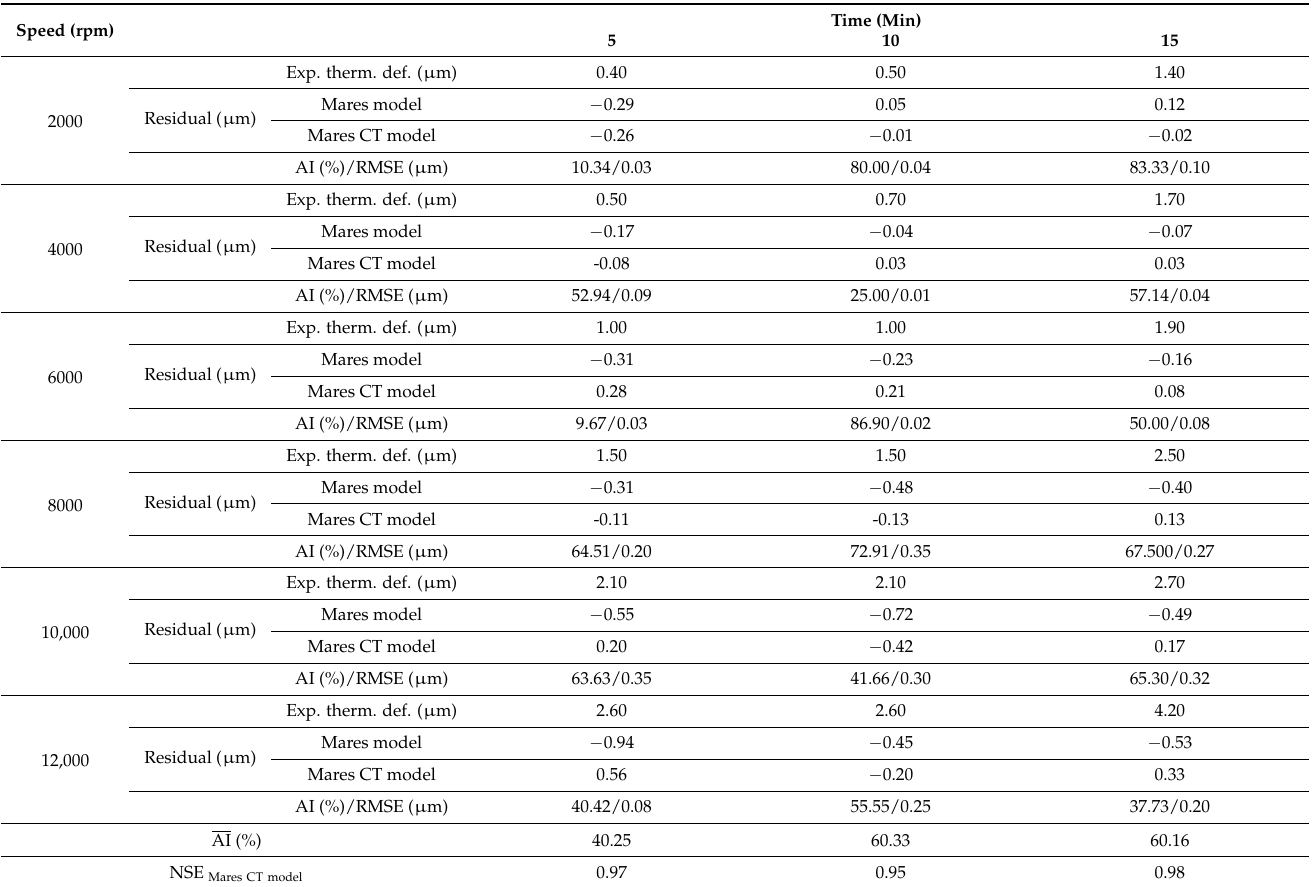
Table 5. Residual thermal errors, AI, RMSE, and AI between the Mares and Mares CT models with regard to the experimental thermal deformation (exp. therm. def.) and the NSE of the Mares CT model over the experimental thermal deformation (exp. therm. def.) in the dynamic operation at a constant coolant temperature of 26 ◦ C, a flow rate of 5 LPM, and ambient temperature of 26 ◦ C with different spindle rotating speeds of a CNC machine with a direct-drive